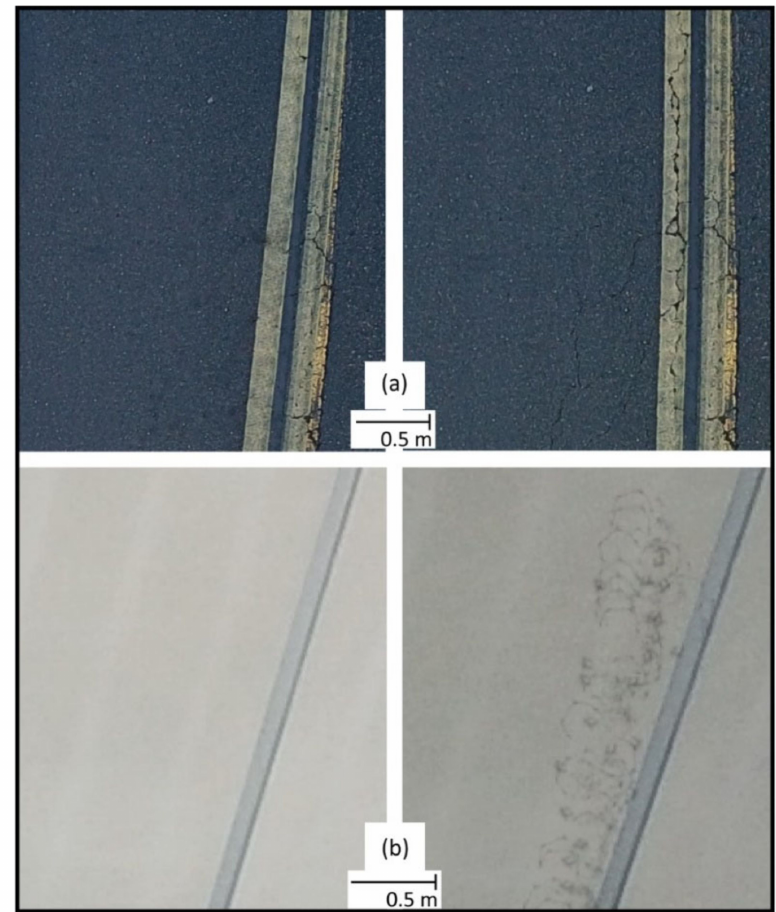
Figure 3. Examples of damage simulation in baseline (left images, ( a ) and ( b )) and time- n (right images, ( a ) and ( b )) pairs. Removal of cracks in baseline images is shown ( a ) and addition of cracks to time- n images is shown ( b